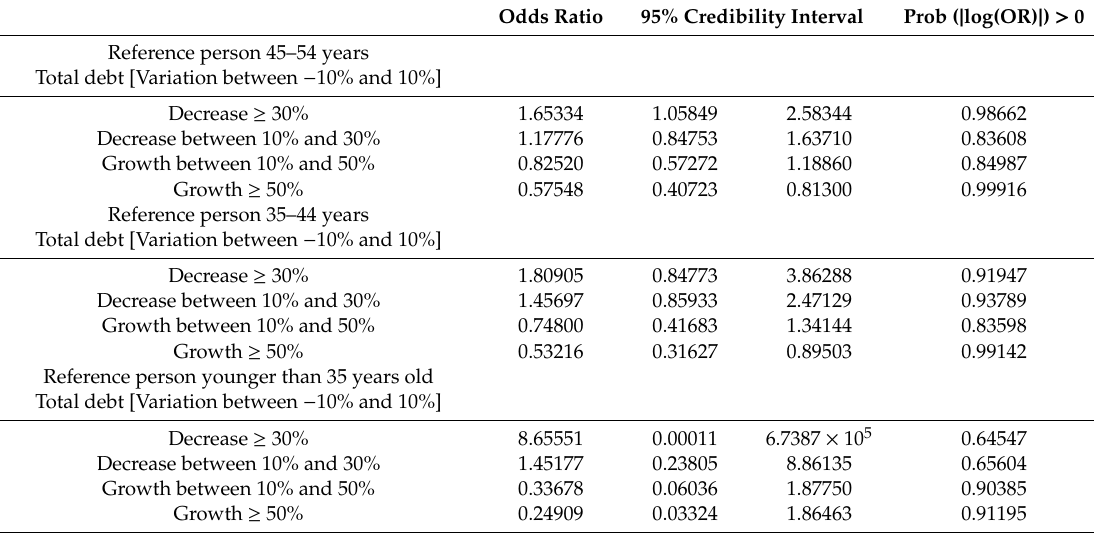
Table 14. Association between the variation in total debt and good and very good self-perceived health. Odds Ratio 95% Credibility Interval Prob ( | log(OR) | ) >